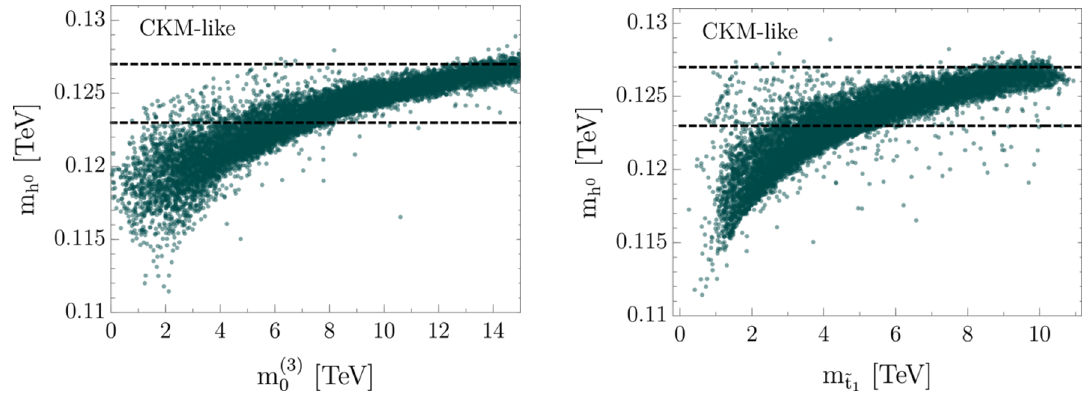
Figure 8 . Higgs mass versus the input parameter at the GUT scale m (3) lightest stop at the SUSY scale